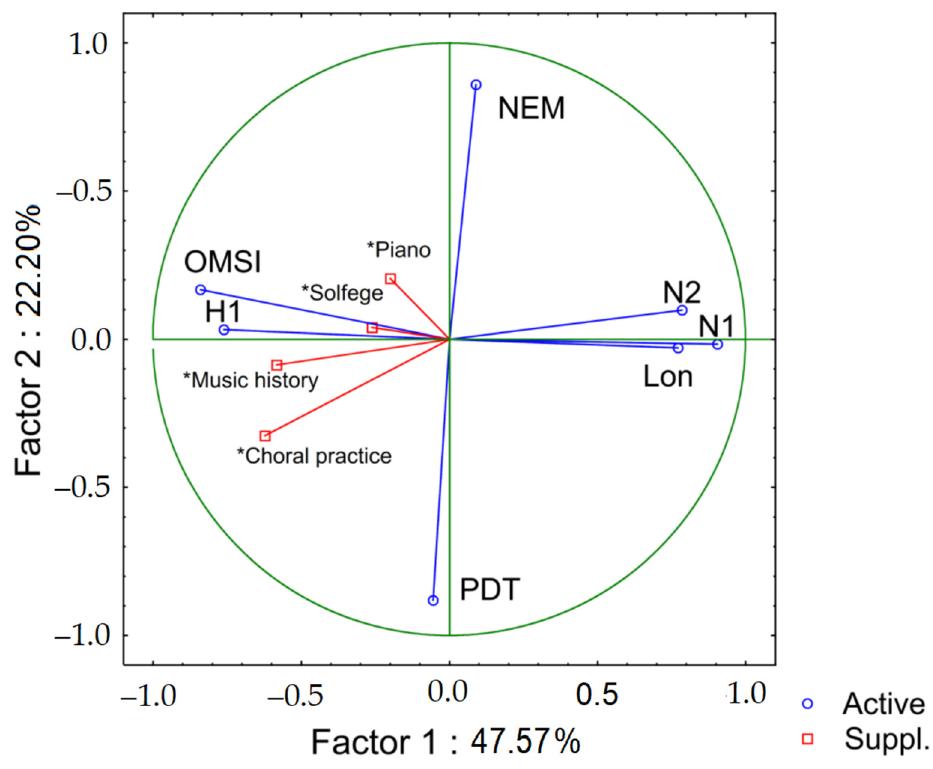
Figure 1. Principal components